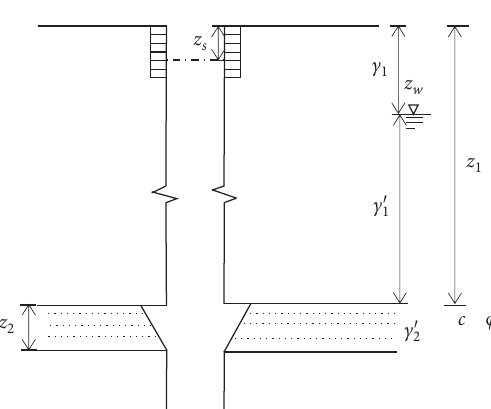
Figure 2: Diaphragm wall passing through weak